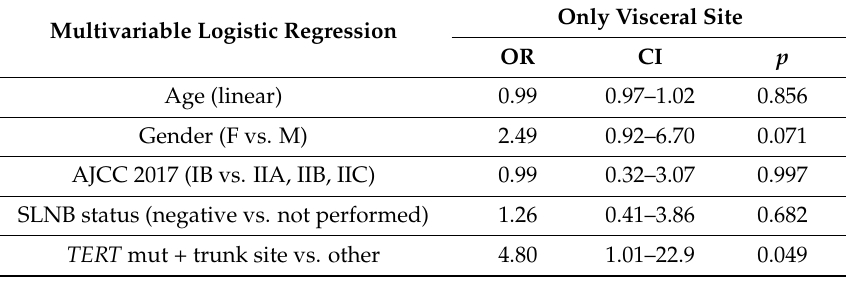
Table 7. Multivariate logistic regression in Istituto Valenciano de Oncologia